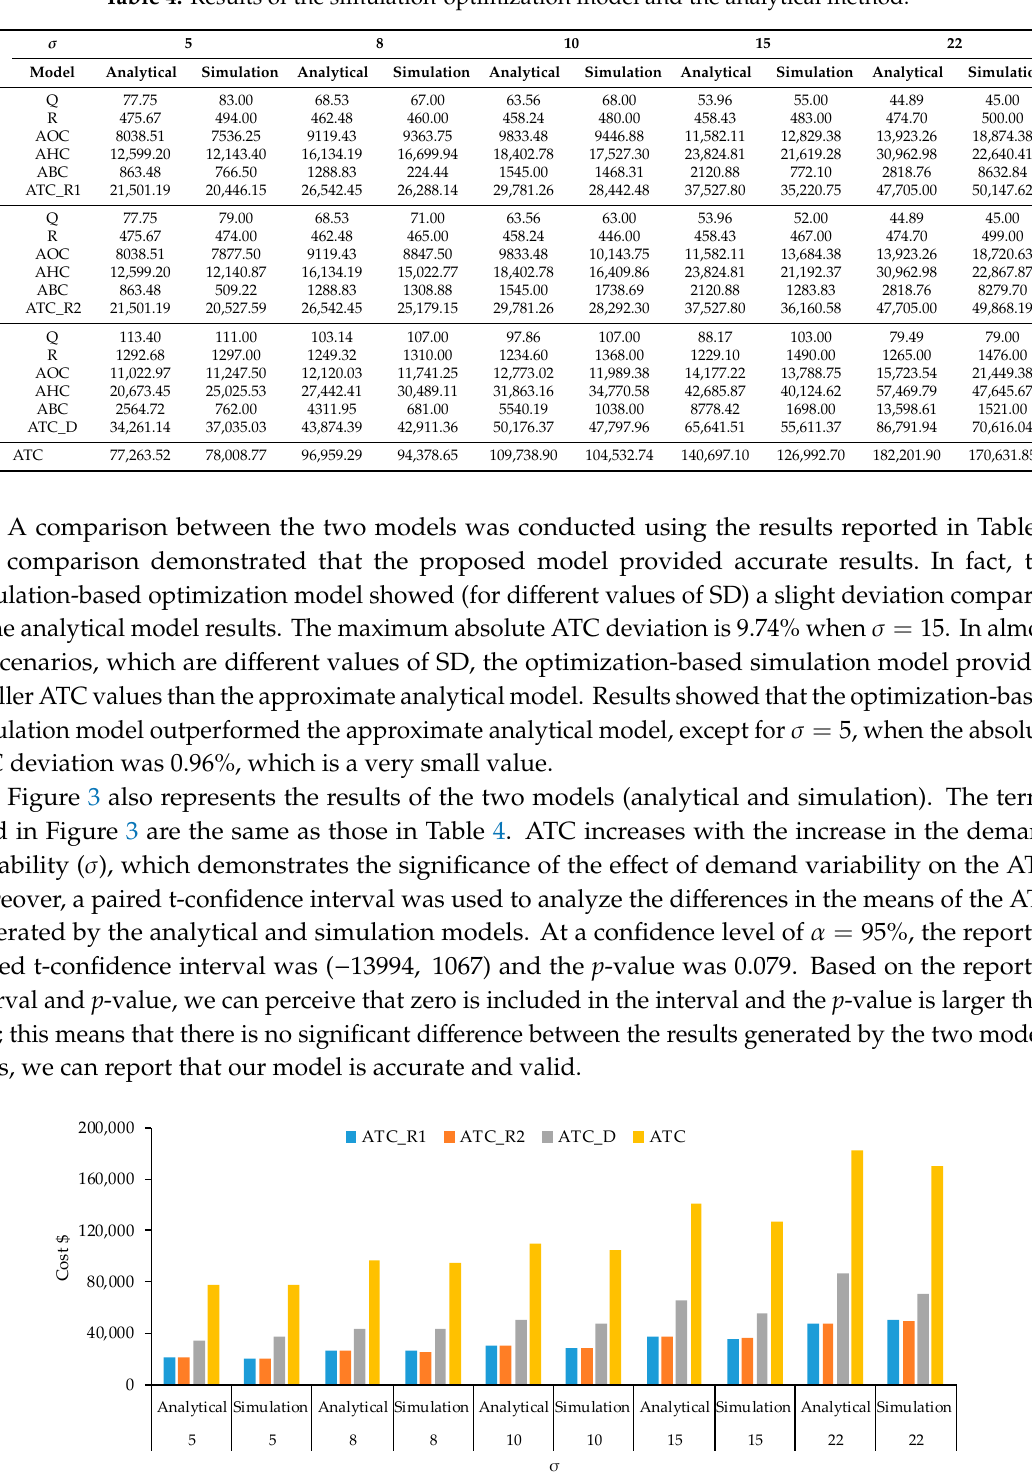
Figure 3. Total annual cost for the system (ATC) of R1, R2, and DC.